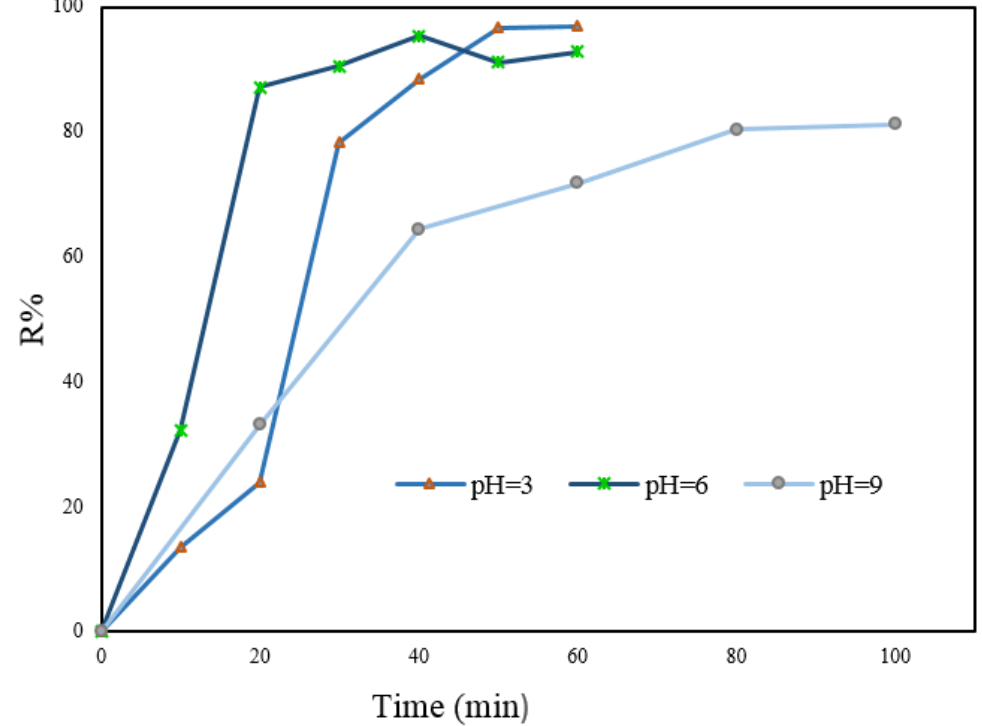
Fig. 15. Graph showing the effect of pH on the removal of methylene blue Fig (15): Graph showing the effect of pH on the removal of methylene blue dye